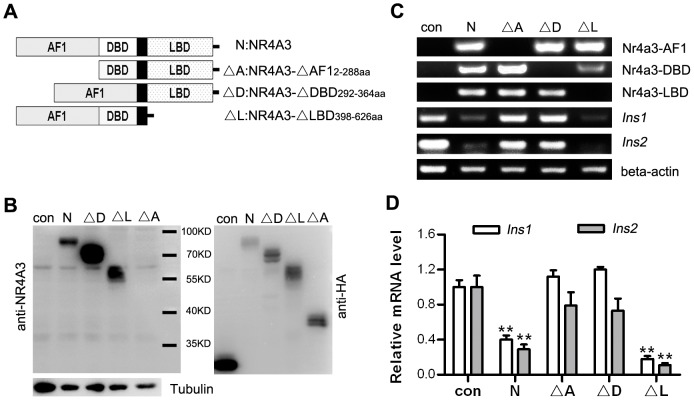
Possible roles of NR4A3 in modulating the expression of insulin genes in MIN6 cell lines.(A) Diagram of constructed wild-type and deletion forms of NR4A3 cDNA. (B) Verification by western blotting MIN6 cell lines stably over-expressing NR4A3 or its deletion forms. (C) mRNA levels of NR4A3 or two insulin genes (Ins1 and Ins2) detected with reverse transcription PCR. Each image is representative of at least three experiments. (D) Semi-quantitative analyses of Ins1 and Ins2 mRNA levels normalized to beta actin in various stable cell lines (n = 5). ** P<0.01 vs. the control cells. Data are representative of three clone lines. Con, cell line transfected with vector encoding GFP; N, cell line expressing the wild-type NR4A3; ΔA, cell line expressing the 2–288 amino acid (aa) deletion of AF1 (activation function-1 domain); ΔD, cell line expressing the 292–364 aa deletion of the DNA binding domain (DBD); ΔL, cell line expressing the 398–626 aa deletion of the ligand binding domain (LBD). The C terminal of all exogenous genes was HA-tagged to facilitate identification with western blotting.